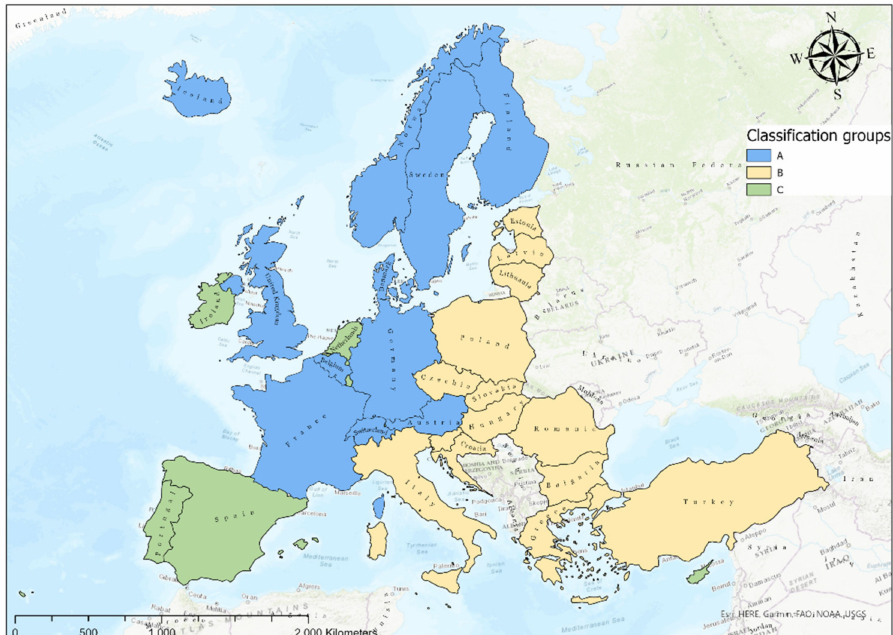
Figure 6. Spatial distribution of the cluster analysis of the EU-countries [own